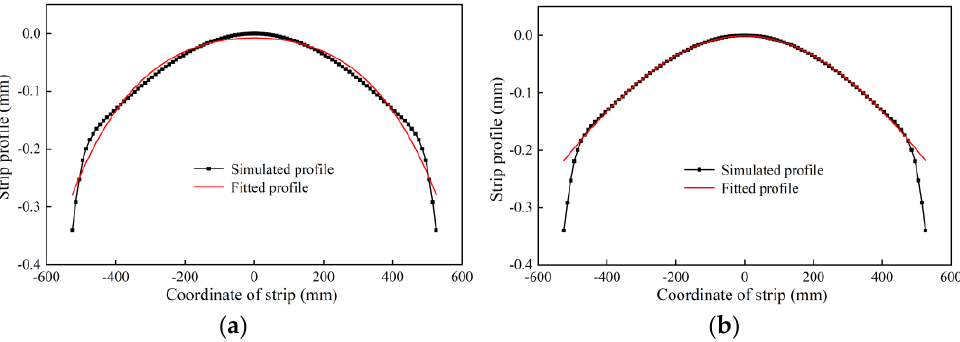
Figure 5. Data fitting of strip profile. ( a ) In full-length range; ( b ) after removing the edge drop.